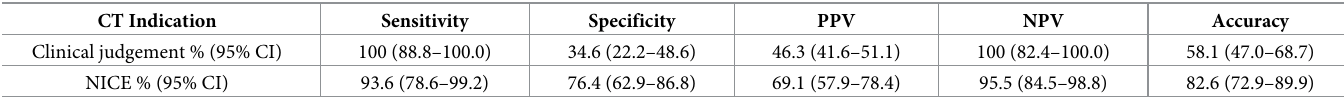
Table 3. Diagnostic tests.